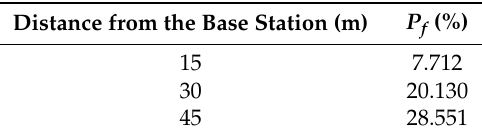
Table 2. MCS results.